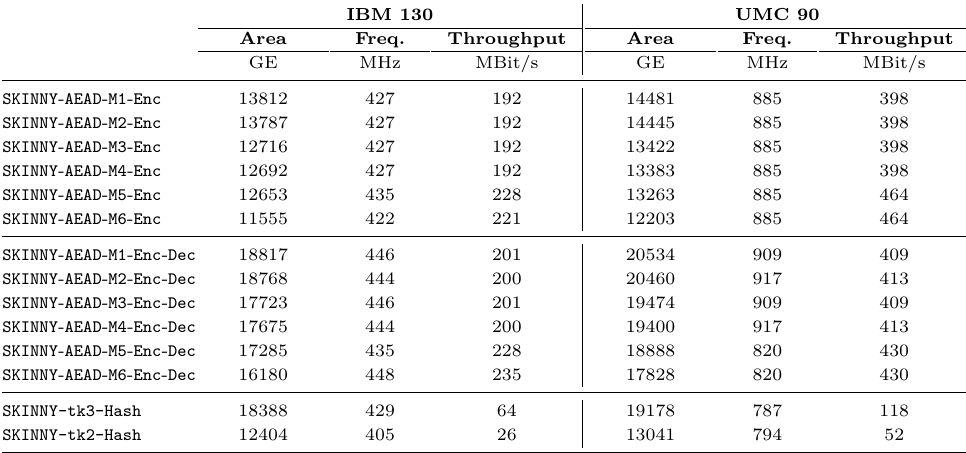
Table 10: SCA-protected (2 shares), round-based ASIC implementations of SKINNY-AEAD and SKINNY-Hash members using IBM 130 and UMC 90 standard cell